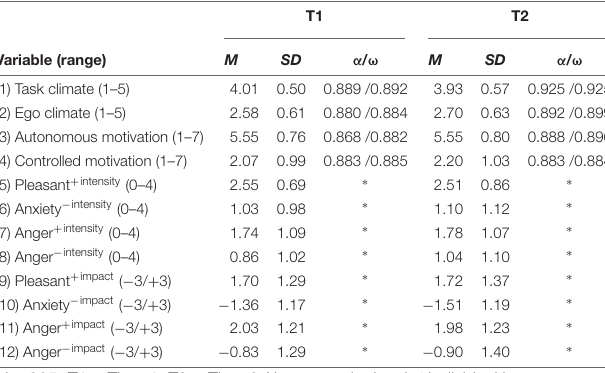
TABLE 1 | Descriptive statistics and Cronbach’s alphas ( α ) and composite reliability ( ω ) of study